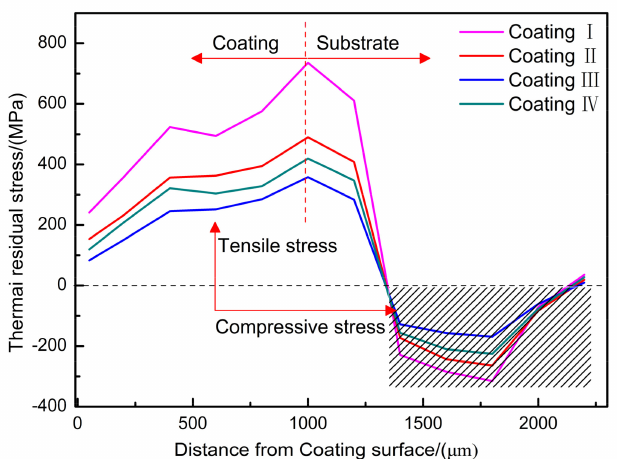
Figure 13. Residual stress distribution along the depth of coating: ( a ) Coating I; ( b ) Coating II; ( c ) Coating III; ( d ) Coating